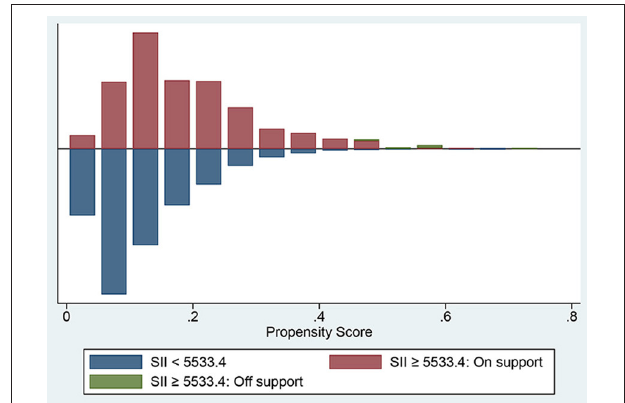
FIGURE 4 | The histogram presenting the range of propensity scores and the corresponding number of matches in high (red) and low (blue) SII groups. SII, systemic immune-inflammation